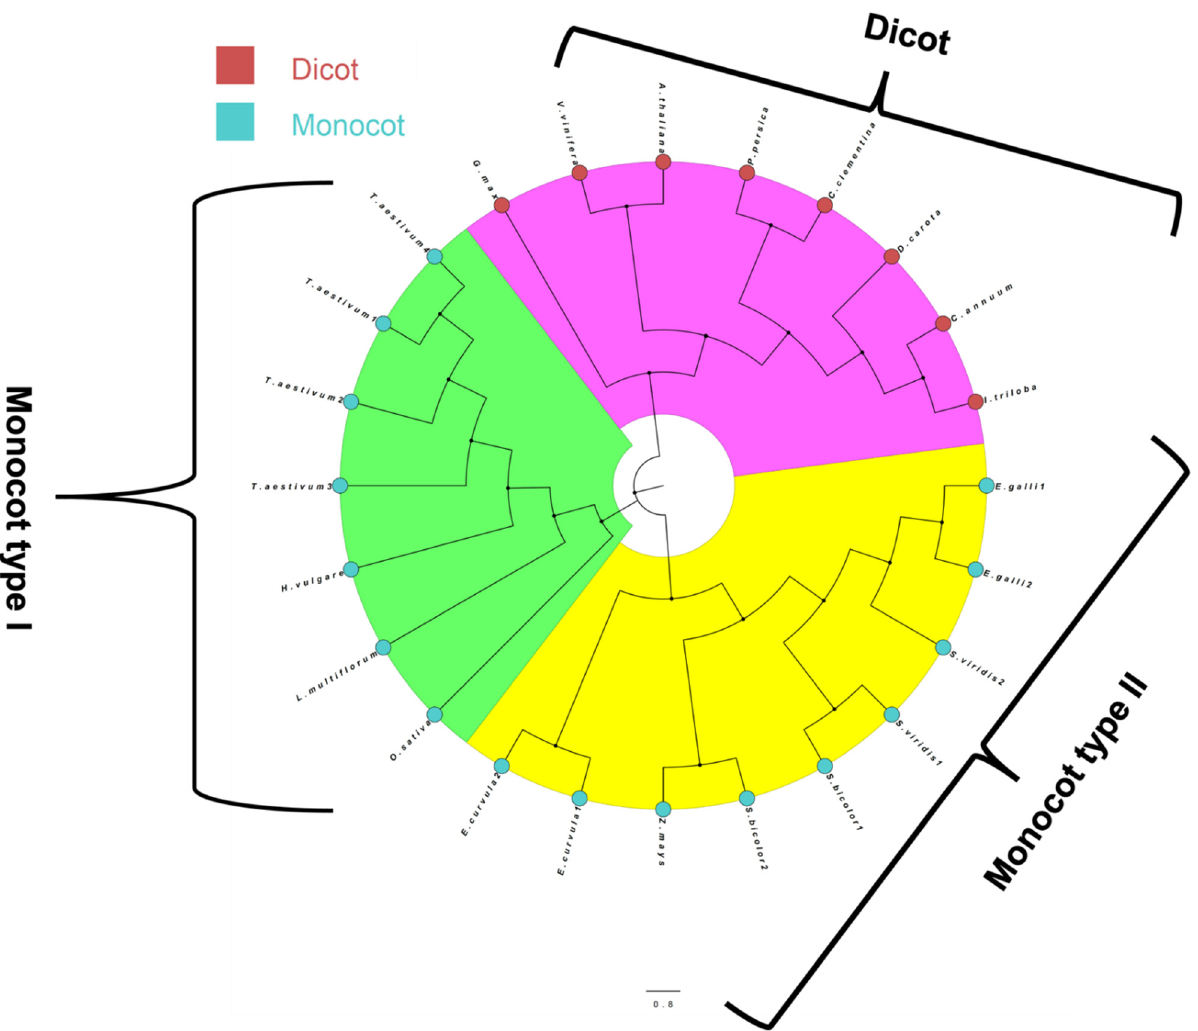
Figure 3. Phylogenetic tree of gene NMO. The tree was constructed using the maximum likelihood statistical technique with 1000 bootstrap repetitions. The circular nodes in red and blue represent dicot and monocot species. The scale bar for evolutionary distance is 0.8. The NMO is broadly divided into three clades; the dicot clade is highlighted with pink color, whereas monocot type I and monocot type II are highlighted with green and yellow, respectively.